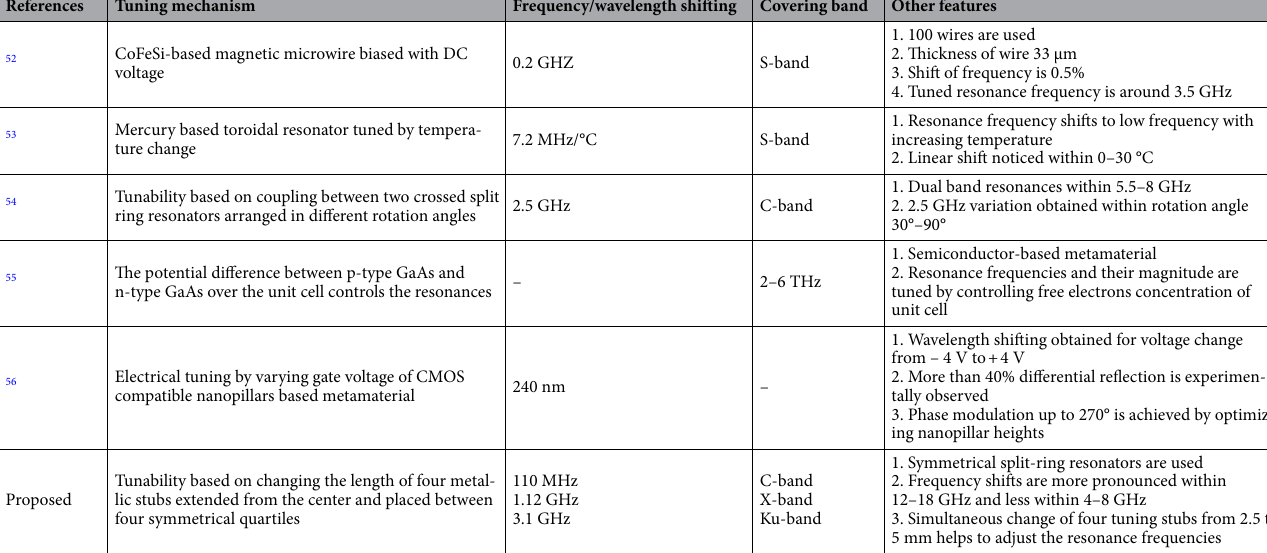
Table 6. A comparative study of proposed MTM with some recently published tunable